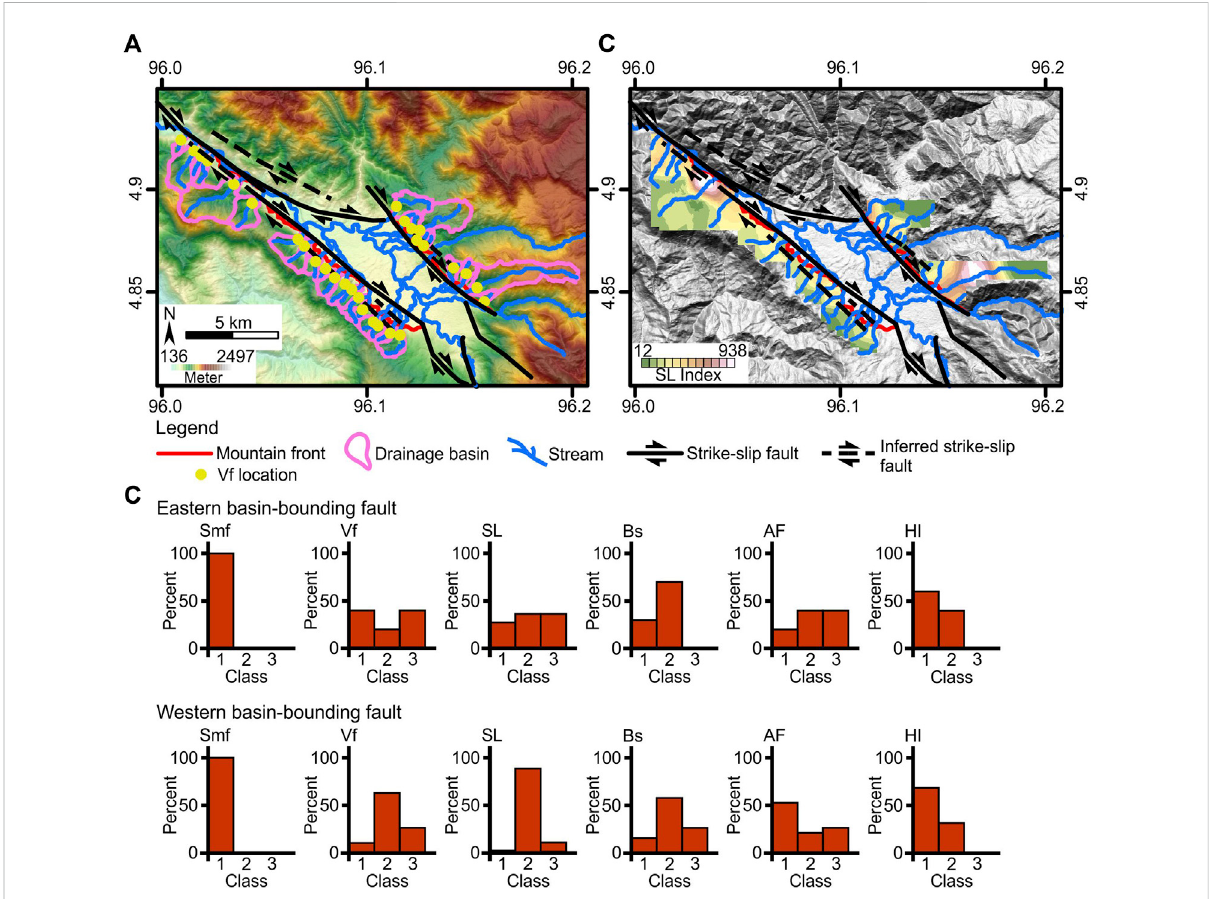
FIGURE 9 The Geumpang Basin: (A) the mountain fronts, faults, and drainage basins, (B) classi fi cation of geomorphic indices, and (C) stream length- gradient map.